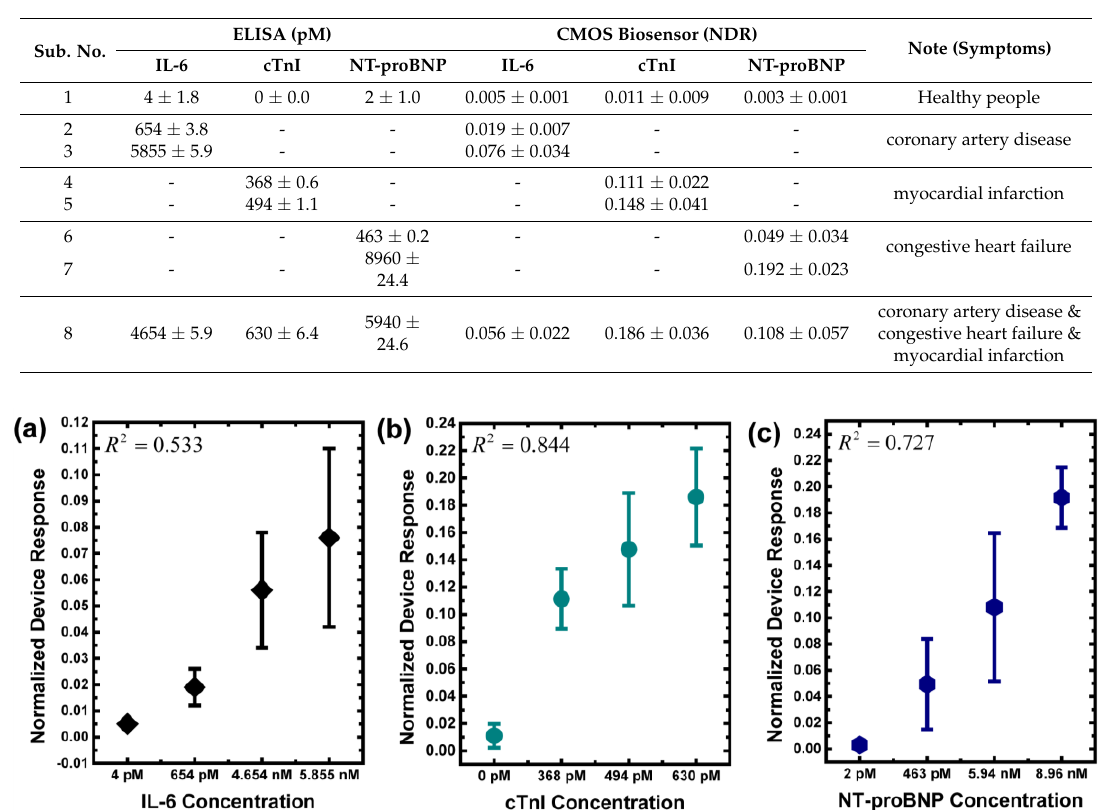
Table 1. The experimental results of IL-6, cTnI, and NT-proBNP in subject serums. It should be noted that the measurement units of ELISA have been transferred to molar concentration.